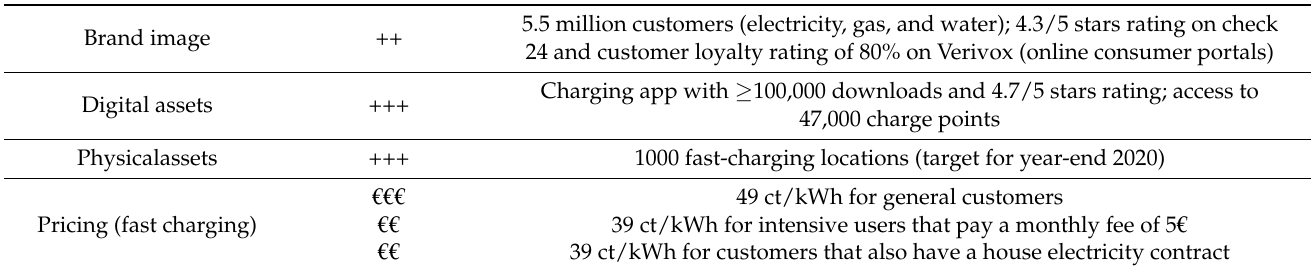
Table 6. Analysis of EnBW [54–60].